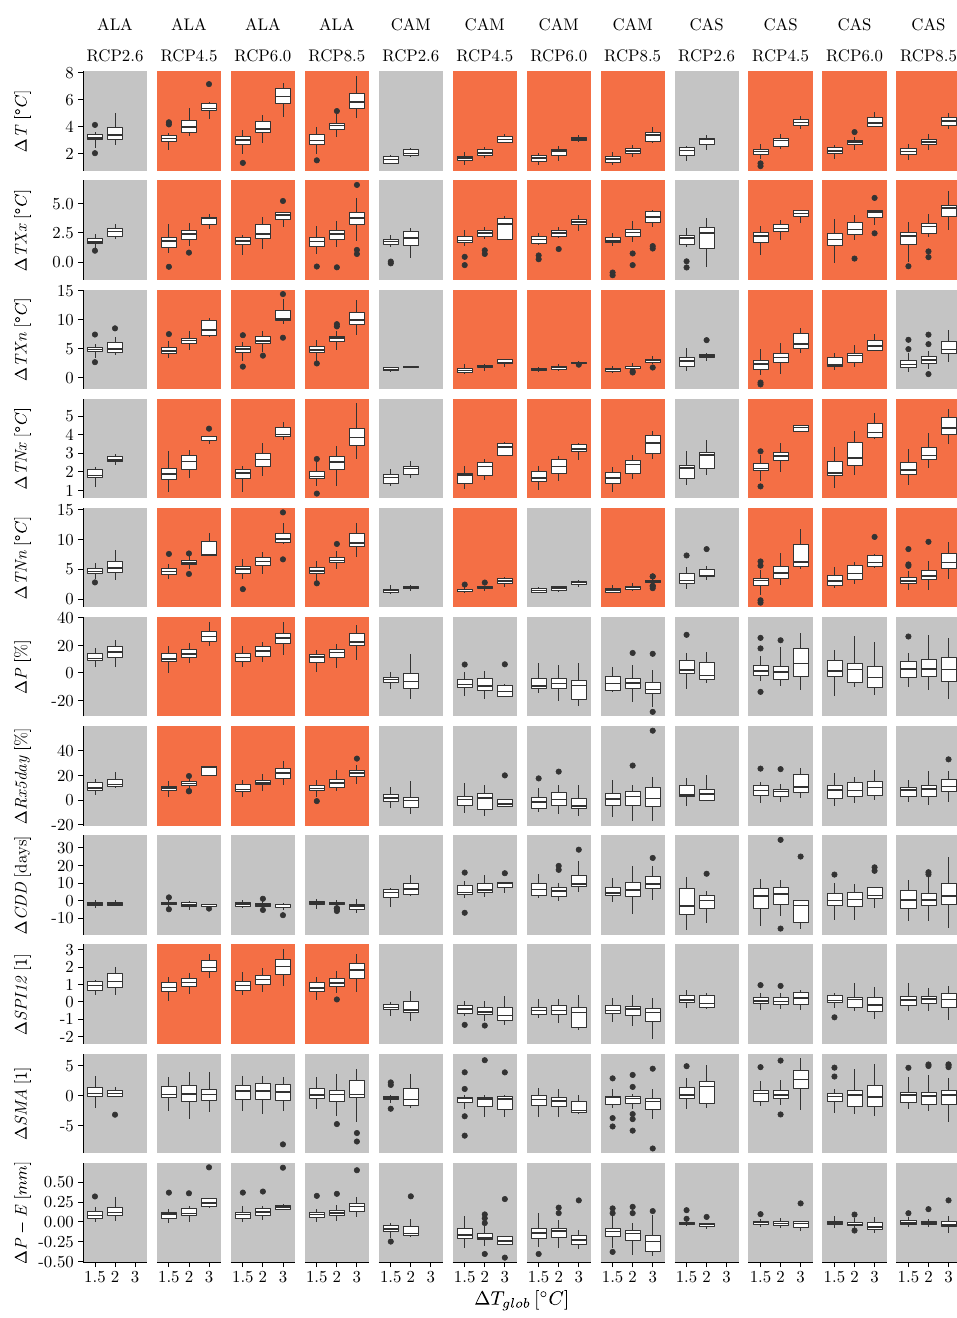
Figure A1. Response of indices (cid:49)T , (cid:49)T Xx , (cid:49)T Xn , (cid:49)T Nx , (cid:49)T Nn , (cid:49)P , (cid:49) Rx5day, (cid:49) CDD, (cid:49) SPI12, (cid:49) SMA, and (cid:49)P − E to global mean temperature increases of 1.5, 2, and 3 ◦ C based on CMIP5 simulations of ensemble member r1i1p1 and averaged over the SREX regions ALA, CAM, and CAS. The upper and lower hinges of the box plots represent the first and third quartiles. The whiskers extend to the highest (lowest) value that is within 1.5 times the interquartile range of the upper (lower) hinge. The central line of each box plot indicates the median value. Values outside this range are displayed as dots. See Table 2 for a description of the